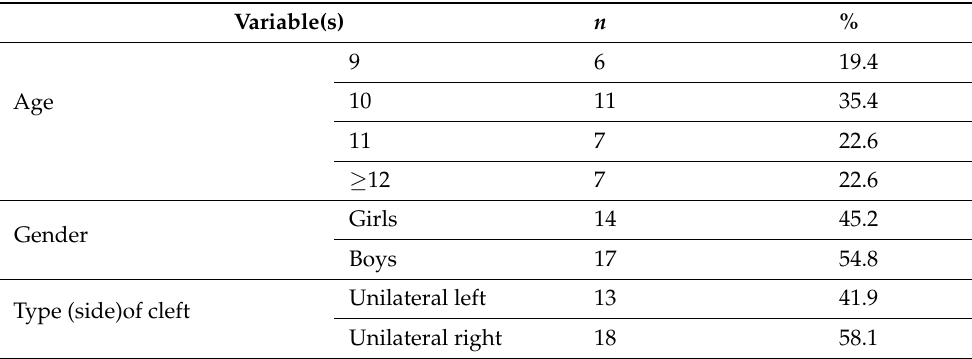
Table 1. Demographic data and cleft